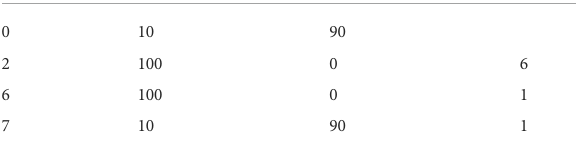
TABLE 1 Gradient elution